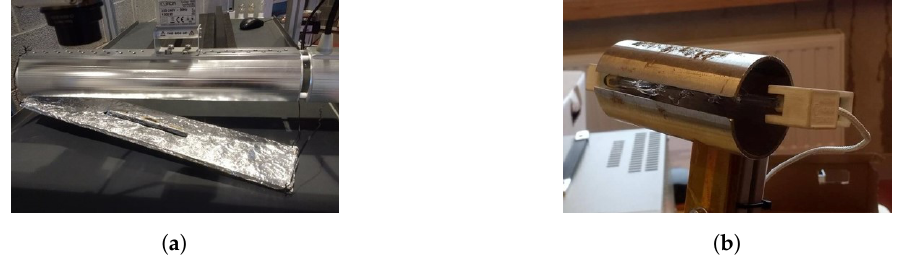
Figure 1. Two experimental set-ups are shown as they are currently used: ( a ) experimental test-setup for dynamic line scanning on a conveyor belt; and ( b ) cylindrical reflector designed to focus the electromagnetic radiation in a thin